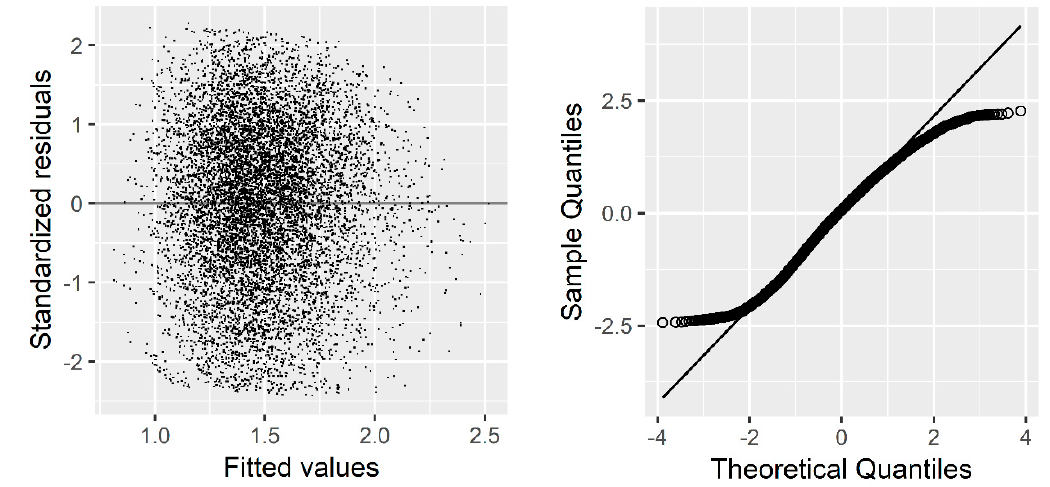
Figure 2. Residual plot and quantile–quantile (QQ) plot (QQ plot depicts the observed values against its standardised normal distribution) of the basic